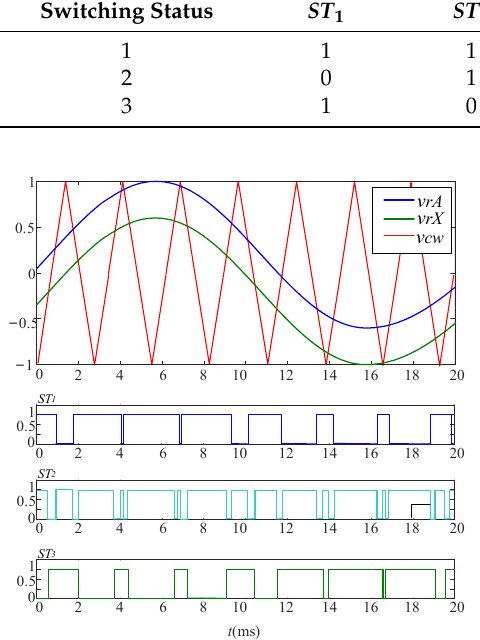
Figure 2. Generation of the single bridge arm PWM signal.